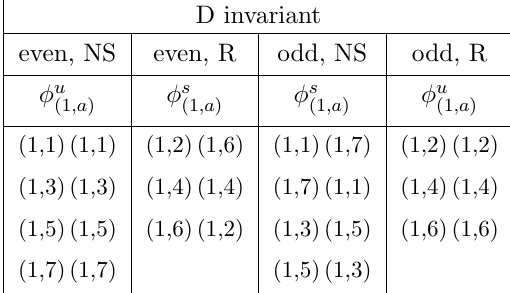
A invariant D invariant